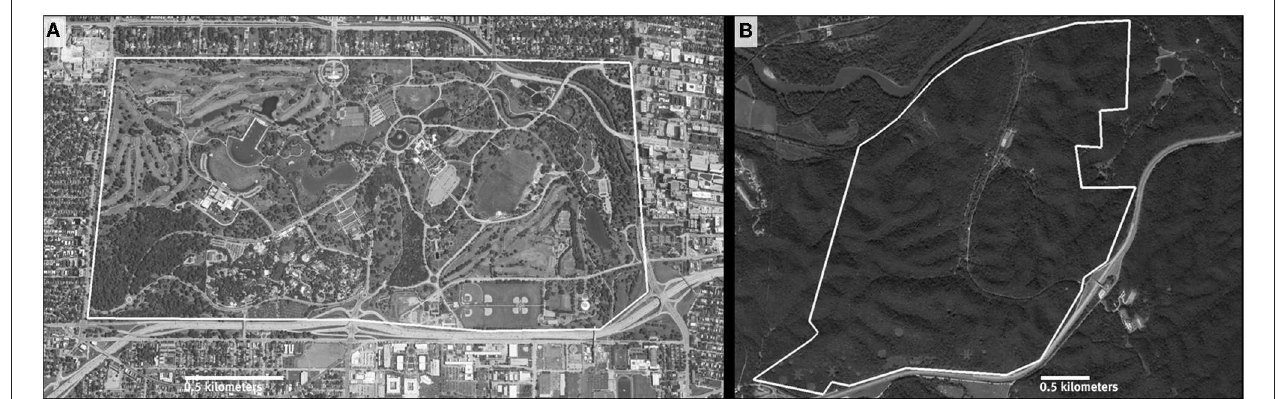
FIGURE 1 | Maps of the field sites, Forest Park (A) and Tyson Research Center (B) in the mortality study of box turtles in Missouri. White line indicates site